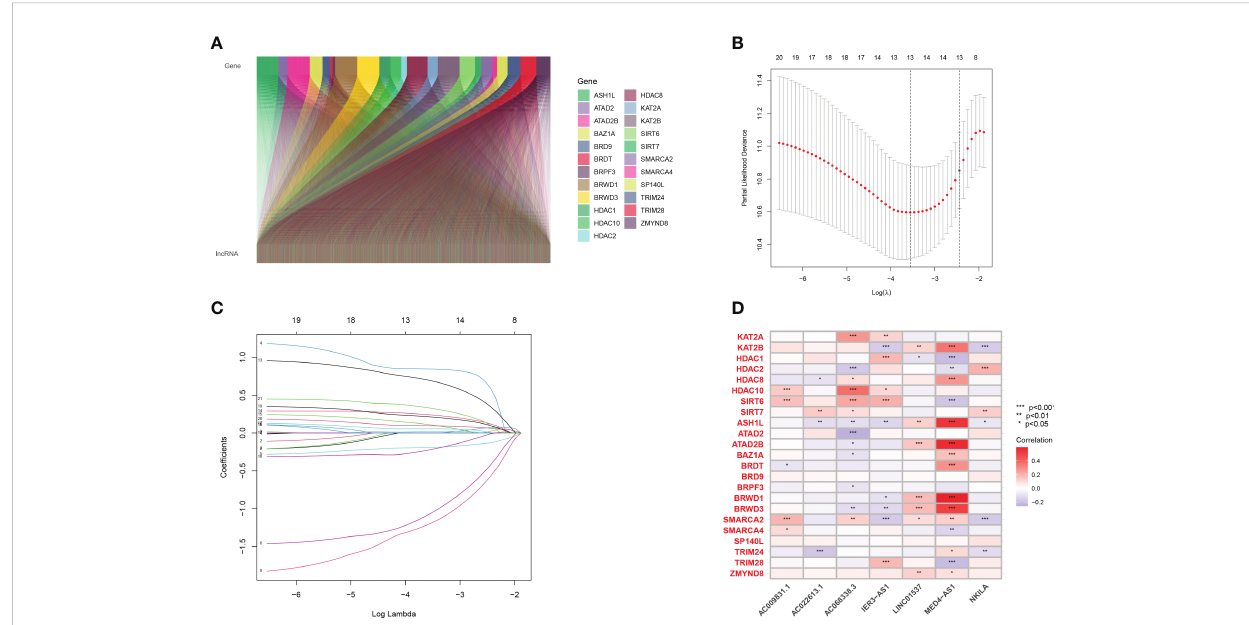
FIGURE 1 Screening prognostic lncRNA tags. (A) Co-expression analysis of 23 genes related to histone acetylation modi fi cation and lncRNAs in LUAD. (B, C) A 10-fold cross-validation of variable selection and LASSO coef fi cient distribution in LASSO regression analysis. (D) Correlation analysis of 7 lncRNAs and 23 genes related to histone acetylation modi fi